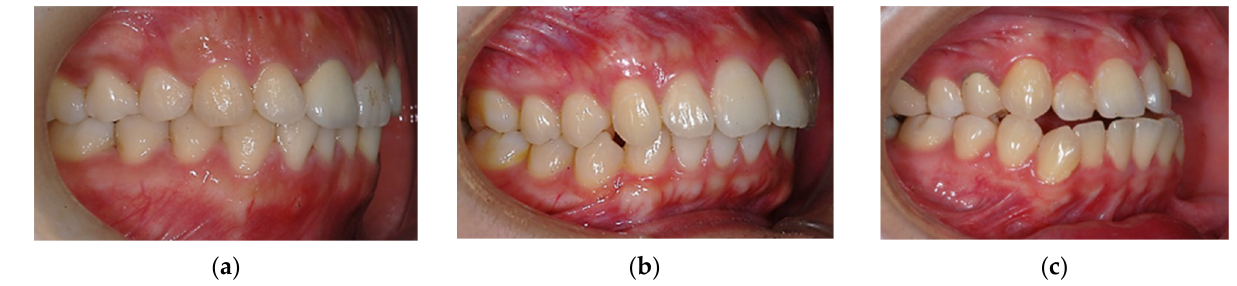
Figure 3. Dental malocclusion based on Angle’s classification: ( a ) Class I molar relationship: the mesiobuccal cusp of the upper first molar occludes the mesiobuccal groove of the lower first molar; ( b ) Class II molar relationship: the mesiobuccal cusp of the upper first molar occludes in front of the mesiobuccal groove of the lower first molar; ( c ) Class III molar relationship: the mesiobuccal cusp of the upper first molar occludes behind the mesiobuccal groove of the lower first molar.